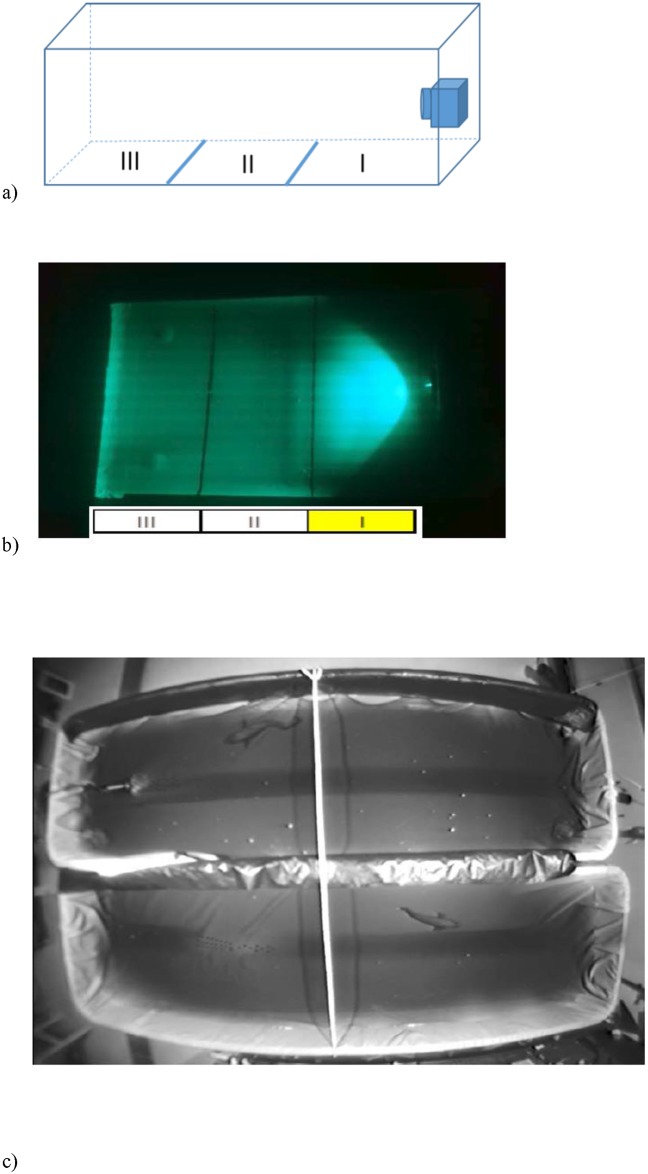
Experimental setup used for studying the behavioural responses of krill and cod to artificial light.The behavioural studies of krill (Meganyctiphanes norvegica) were conducted in a black 80 litre tank (80 cm long x 50 cm wide, water depth 22 cm), with the experimental lamp positioned by the right wall (A). The tank bottom was divided tank into three equal sections (Area I, II and III). Due to the position of the lamp, only a part of Area I was illuminated by the experimental lamp during the experiment (B). Experimental setup used for studying the behavioural responses of cod to artificial light (C). The experimental tanks were 400 cm long, 150 cm wide and 100 cm deep. The experimental lamp was placed in one tank at a time (here seen in the top tank towards the right end). A rope was tied across dividing the two tanks in two equal parts. Infra-red lighting and wide-angle camera were mounted to the ceiling above the two tanks to enable visual observation of activity and position of the cod (Gadus morhua).